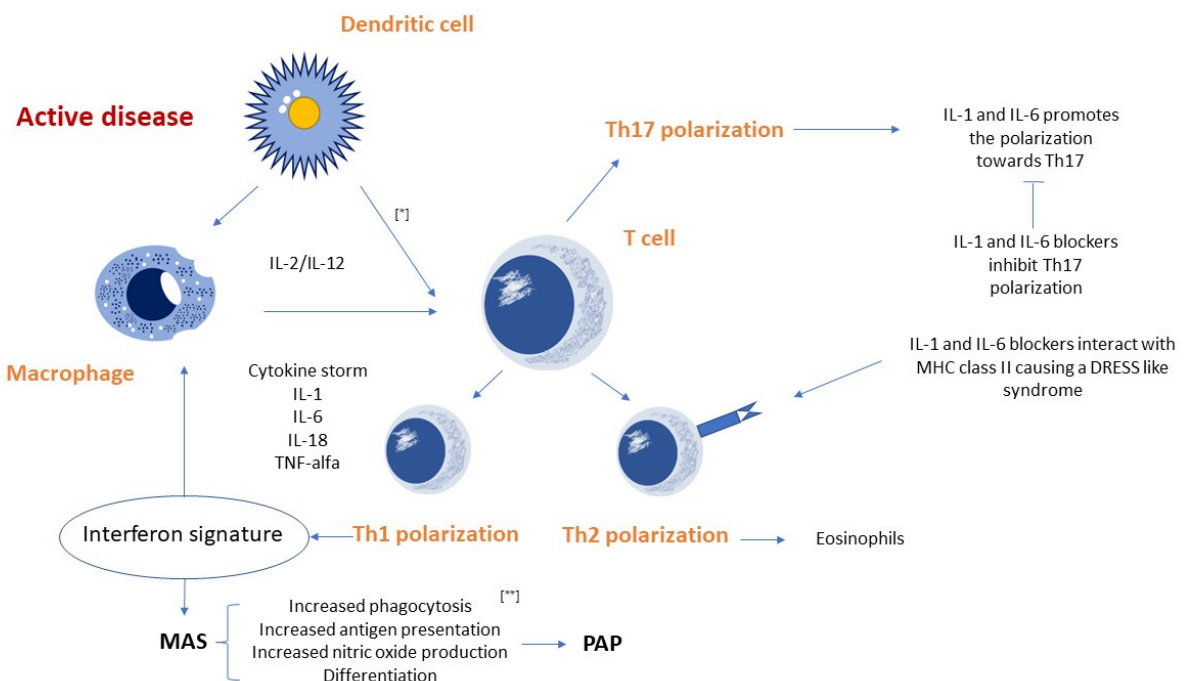
Figure 1. The proposed underlying mechanism of lung involvement in children with systemic juvenile idiopathic arthritis. [*] In cells exposed to interleukin (IL)-2 e IL-12, IL- 18 enhances the synthesis of interferon (IFN) γ , which promotes Th1 differentiation. In particular circumstances, it can trigger a vicious cycle leading to a cytokine storm that favors the development of macrophage activation syndrome. [**] Overexpression of IFN- γ and Th1 cytokines can lead in some murine models to the development of pulmonary alveolar proteinosis.